Question: Write the caption for this figure.
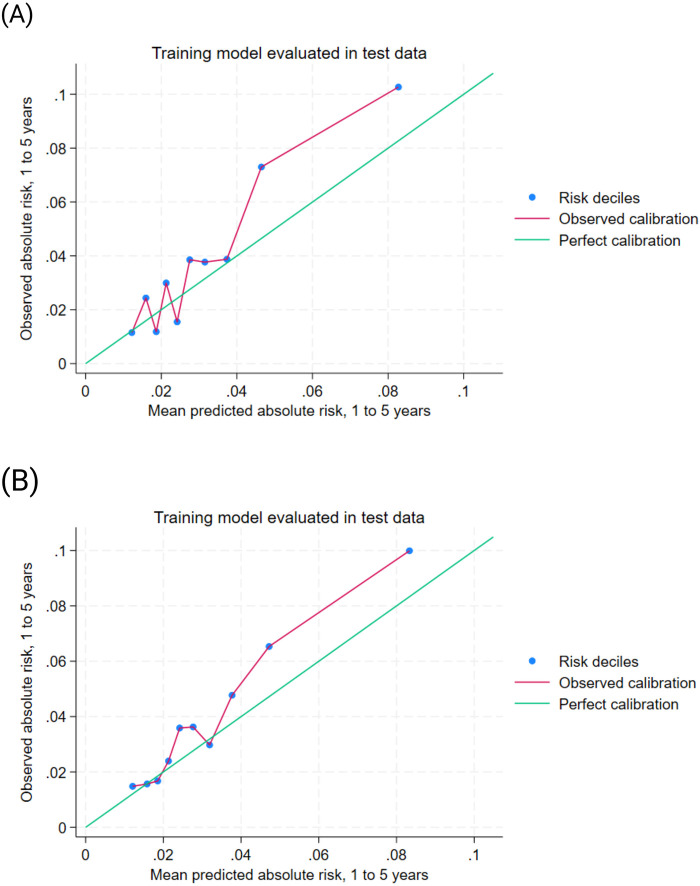
Answer: Calibration plots for the best predictive models of 1–5 year TLR risk. (A) Calibration plot for Cox regression with forward selection; (B) Calibration plot for Cox-LASSO. TLR = target-lesoin revascularization; LASSO, Least Absolute Shrinkage and Selection Operator. Created in BioRender. El-Faramawi, M. (2026) https://BioRender.com/tubl8d3 .